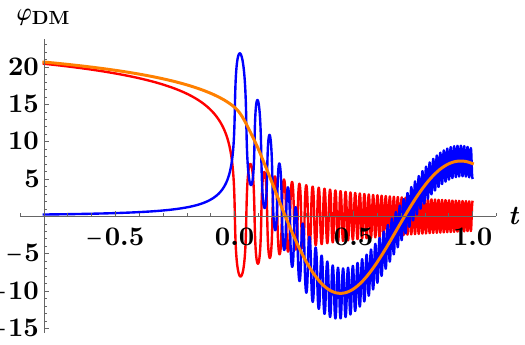
Figure 2 . Field evolution at the end of in(cid:13)ation for ’ DM (orange), (cid:27) (blue), and (cid:11)(cid:30) (red). Field values are normalized by (cid:11)M p H end =m (cid:30) . Time is in units of 2 (cid:25)=m (cid:27) , with t = 0 denoting